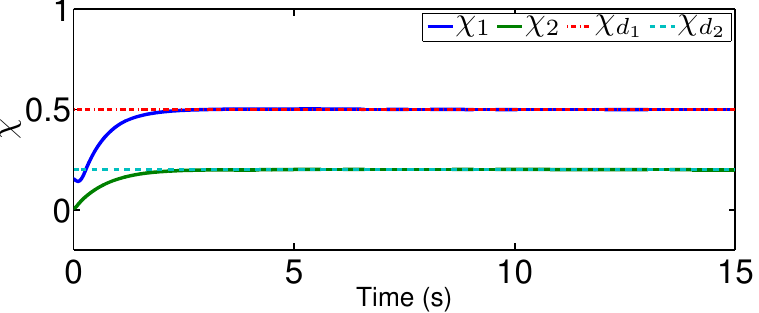
Figure 8. Performance χ under the proposed controller.